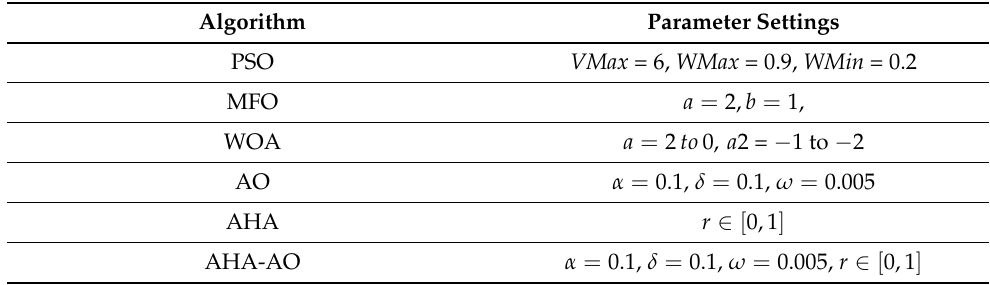
Table 1. Parameter settings of the methods.